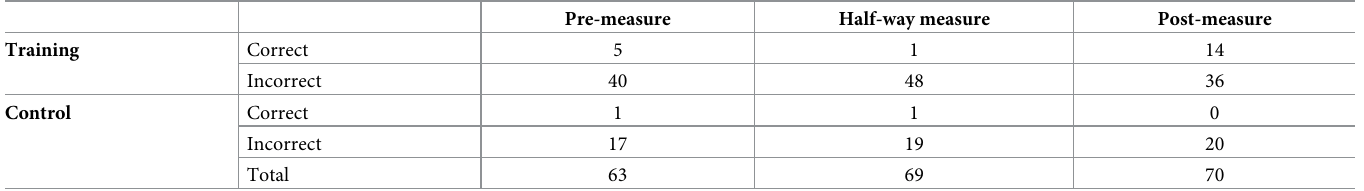
Table 2. Descriptive statistics of participants’ performance of the insight problem at pre-measure, half-way measure and post-measure after checking